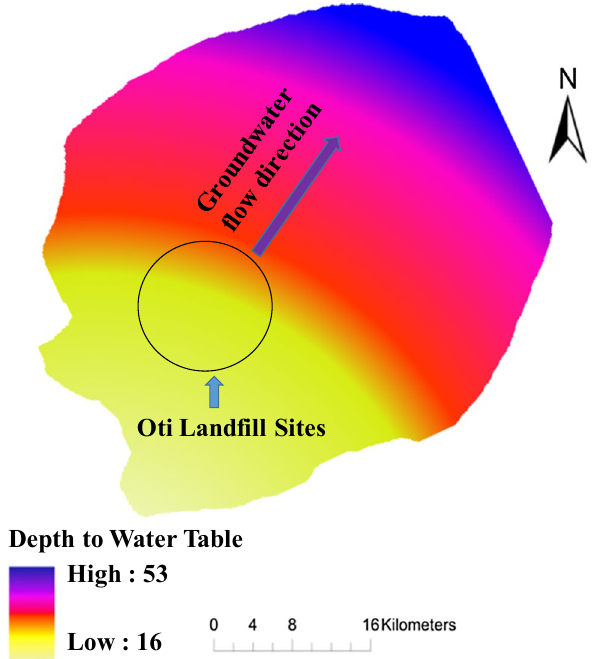
Fig. 2 Map showing the groundwater flow direction to the water table in the Oti